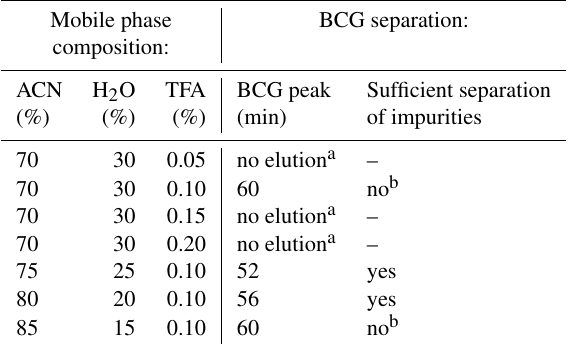
Table 1. Mobile phase compositions and their impact on the BCG